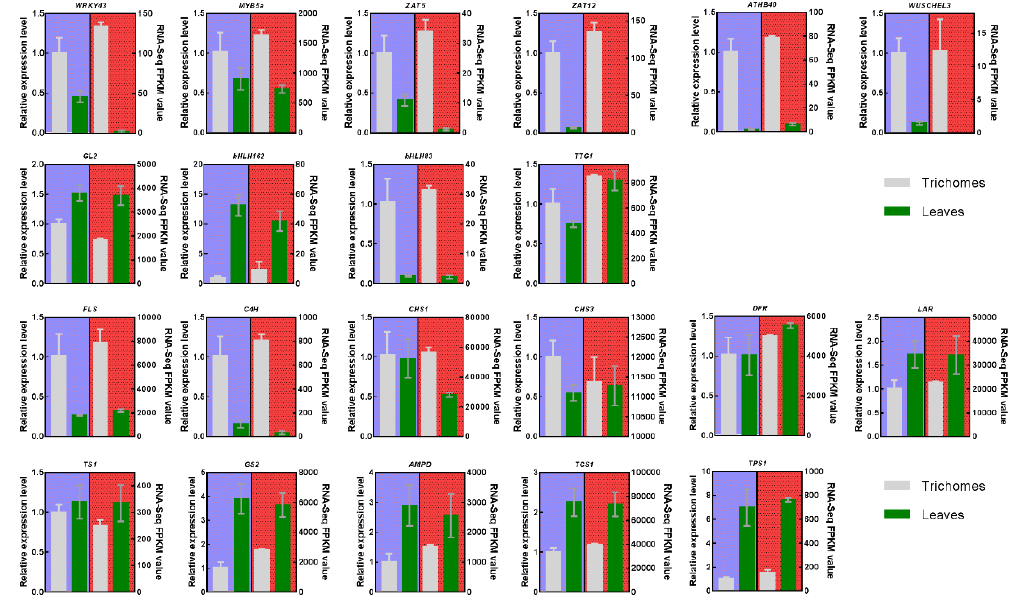
Figure 6. Quantitative RT-PCR validation. Twenty one genes of regulatory TFs and structural genes involved in the trichome development and major secondary metabolic pathways including WRKY43 , MYB5a , ZAT5 , ZAT12 , ATHB40 , WUSCHEL3 , GL2 , bHLH162 , bHLH83 , TTG1 , FLS , C4H , CHS1 , CHS3 , DFR , LAR , TS1 , GS2 , AMPD , TCS1 , and TPS1 were selected for RT-qPCR determination. The GAPDH gene was used as an internal